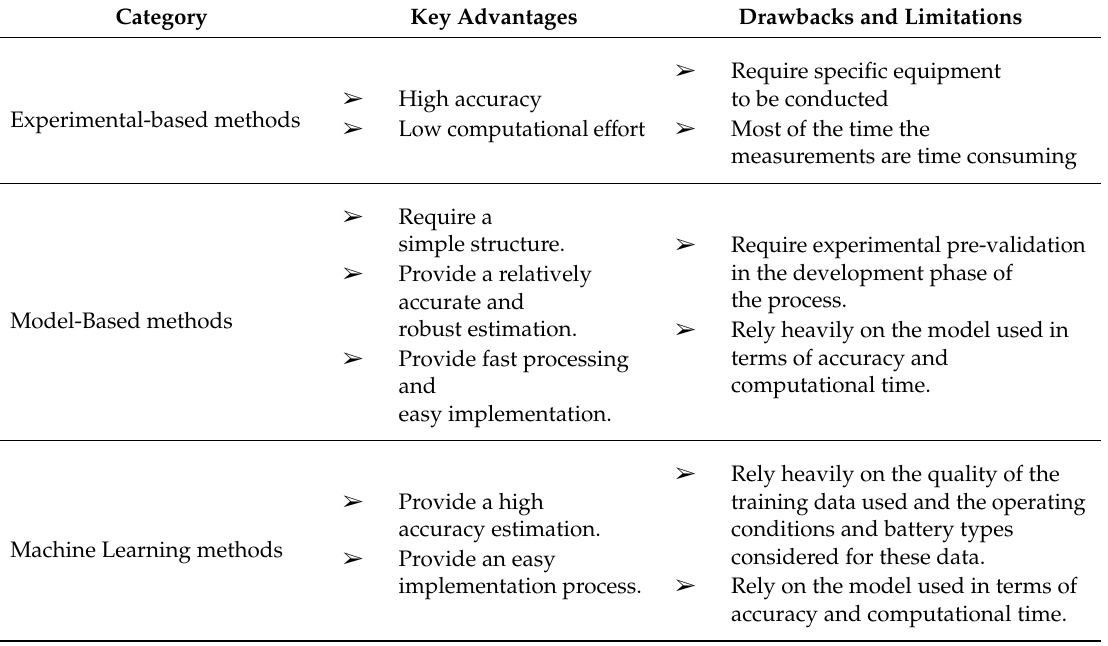
Table 4. Qualitative comparison of the SOH estimation methods.